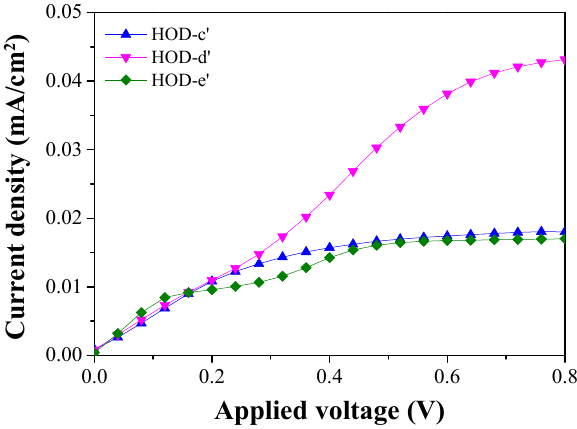
Figure 6. J-V characteristics of the HOD-c’, HOD-d’, and HOD-e’.